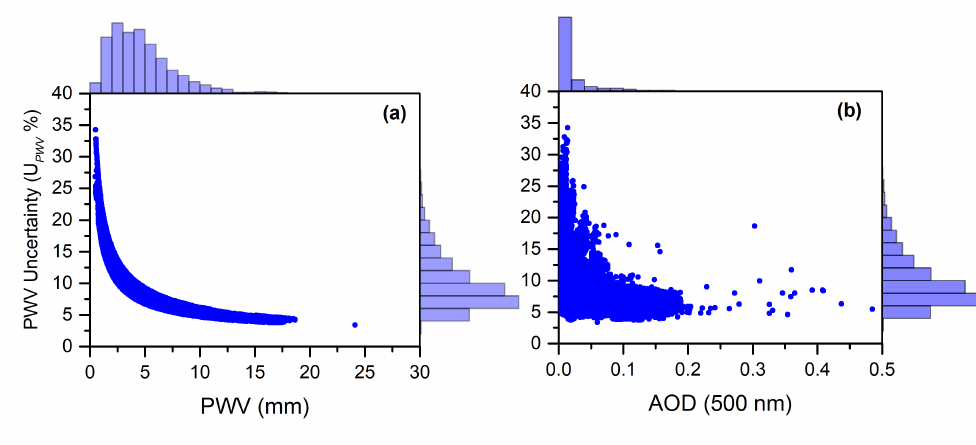
Figure 6. Relative uncertainty of EKO PWV (%) versus ( a ) EKO PWV (mm) and ( b ) AOD at 500 nm